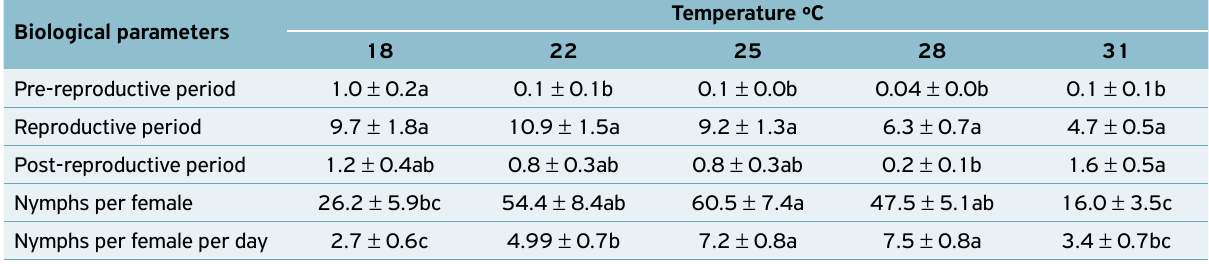
Table 2. Mean time of pre-breeding, reproduction, and post-reproduction periods, and the mean number of nymphs per female (days ± SE) of Aphis craccivora at different constant temperatures and a 12-hour photophase in